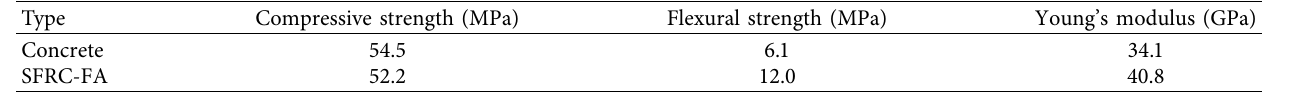
Table 4: Concrete and SFRC-FA material properties.